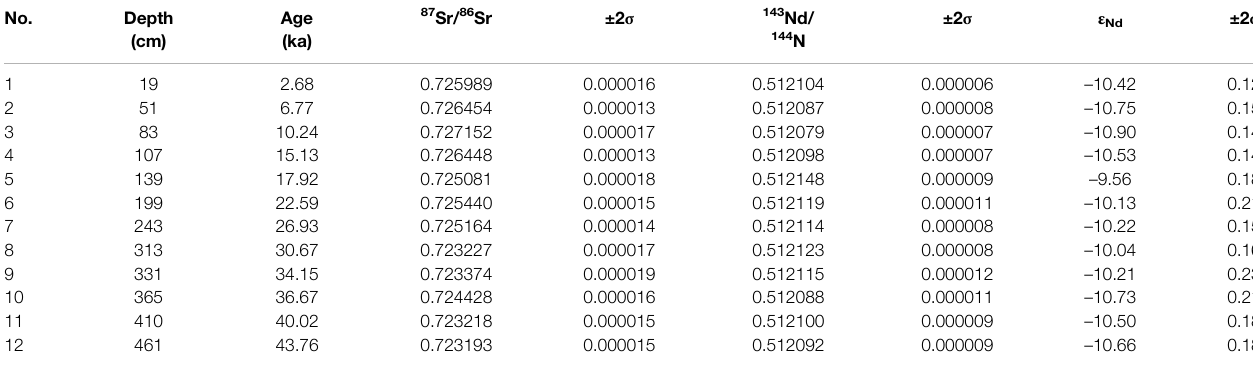
TABLE 1 | Sr and Nd isotopic compositions of Core MD05-2896 over the last 45 ka.